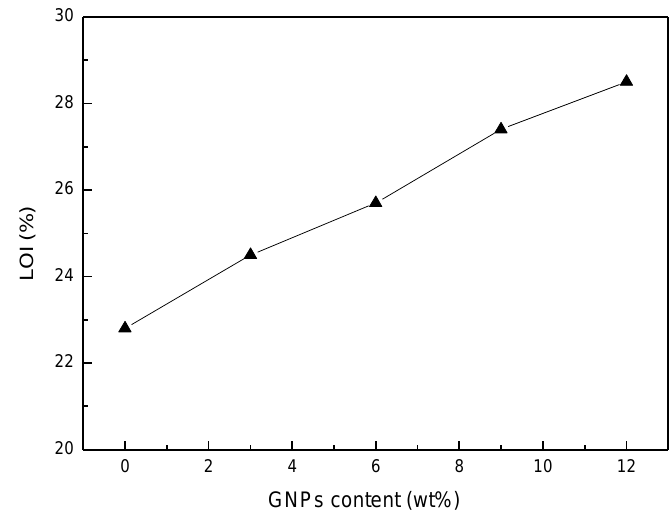
Figure 5. The LOI values of the WPCs with added GNPs.